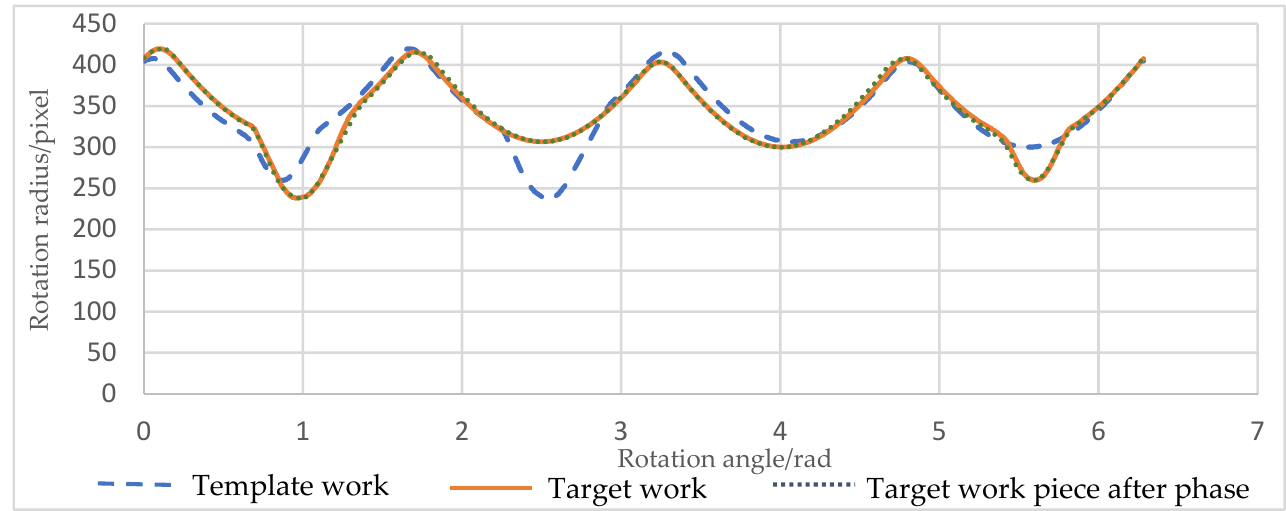
respectively, and if m (cid:54) = n , the arrays with more pixel points need to be isometric sparse processed. The relationship between X [